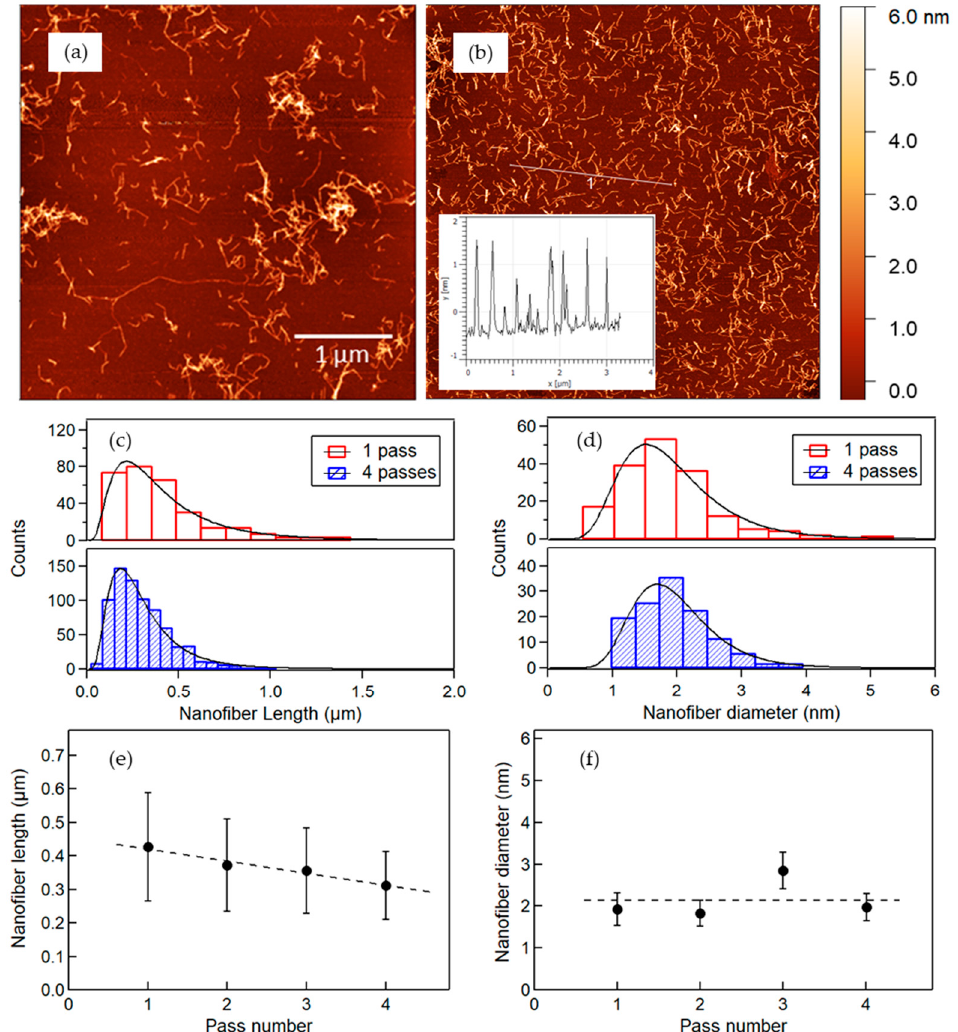
Figure 3. AFM micrographs of nanofiber after 1 pass ( a ) and 4 passes ( b ) through the microfluidizer. A line profile in ( b ) indicating relatively uniform thickness of nanofibers of a few nanometers. Length ( c ) and diameter ( d ) histograms for 1- and 4-pass specimens. The curves are best fits of a log-normal distribution function. Mean length ( e ) and diameter ( f ) of nanofibers as a function of the number of passes through the microfluidizer. The dash lines are the linear regression as a guide to the eye. Both the mean length and diameter vary little.